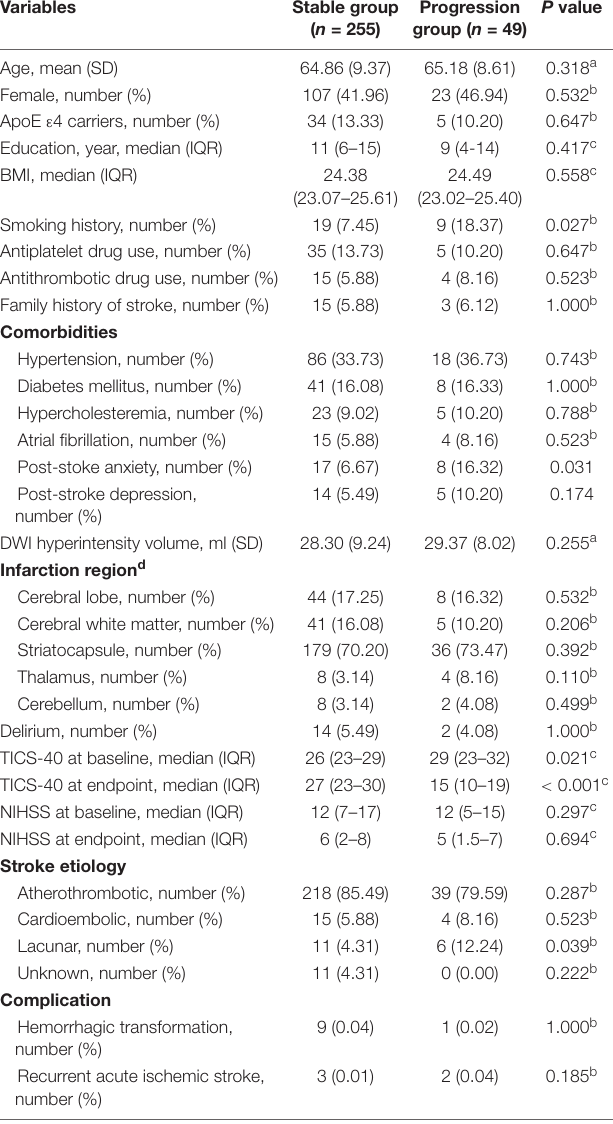
TABLE 1 | Demographic data of the